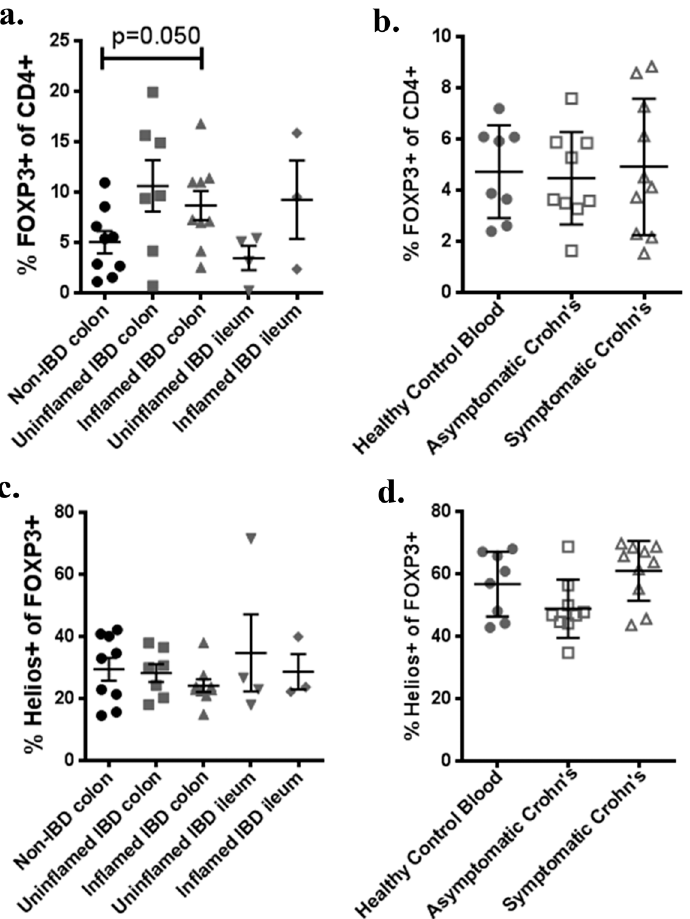
Fig 3. Increased intestinal FOXP3 + T cells in IBD are not predominantly Helios - . Homegenized LPL (a,c) or PBMC (b,d) were thawed and stained according to Table 1, or with isotype control antibodies. Gating on